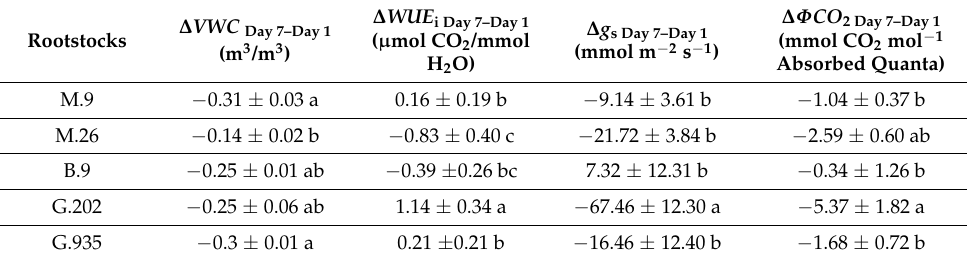
Table 1. Changes in instantaneous water use efficiency ( WUE i ), stomatal conductance ( g s ) and maximum quantum efficiency of CO 2 assimilation ( Φ CO 2 ) of Ambrosia TM scion on five rootstocks, along with the decline in soil volumetric water content ( VWC ) from Day 1 to Day 7 after irrigation in the greenhouse